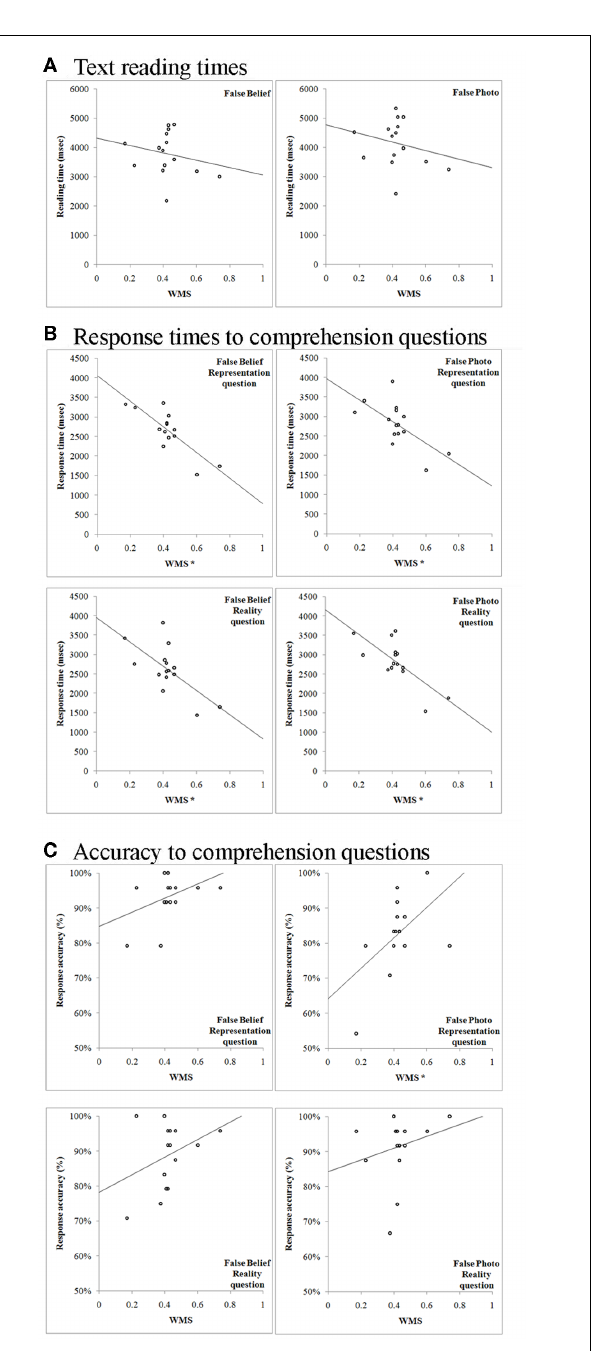
FIGURE 2 | Scatter plots forWMS correlations with reading time (A), response times (B), and response accuracy (C). Significant correlations are marked with an